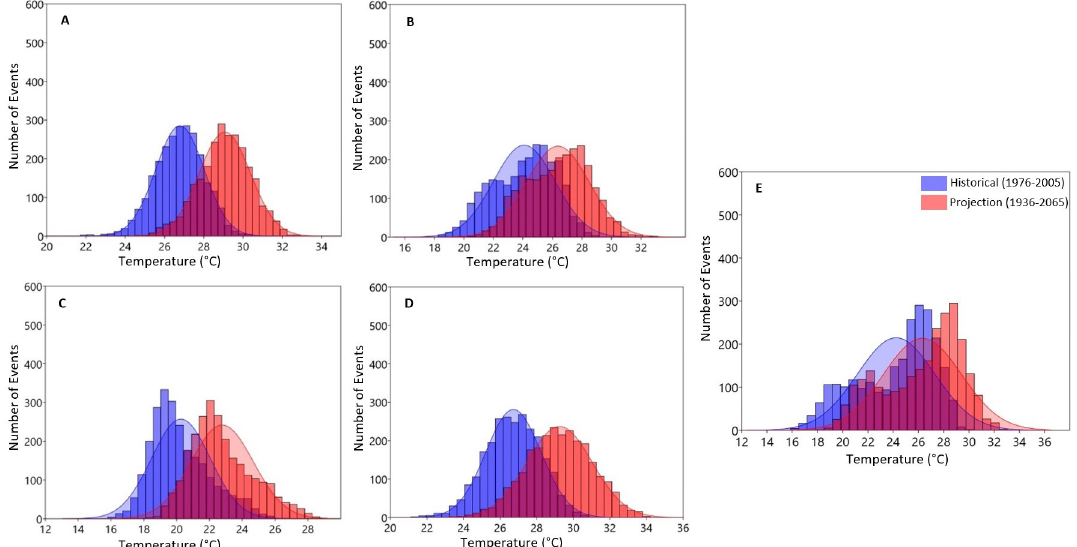
Fig 7. Probability distribution estimation of daily seasonal A) Summer, B) Autumn, C) Winter, D) Spring and E) annual maximum temperatures Over Olifants Catchment (1976–2005 vs.